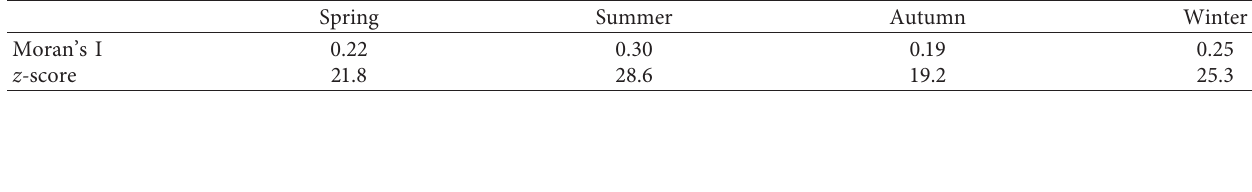
Table 2: Moran’s I and the z -scores for the diurnal variation of precipitation in Figure